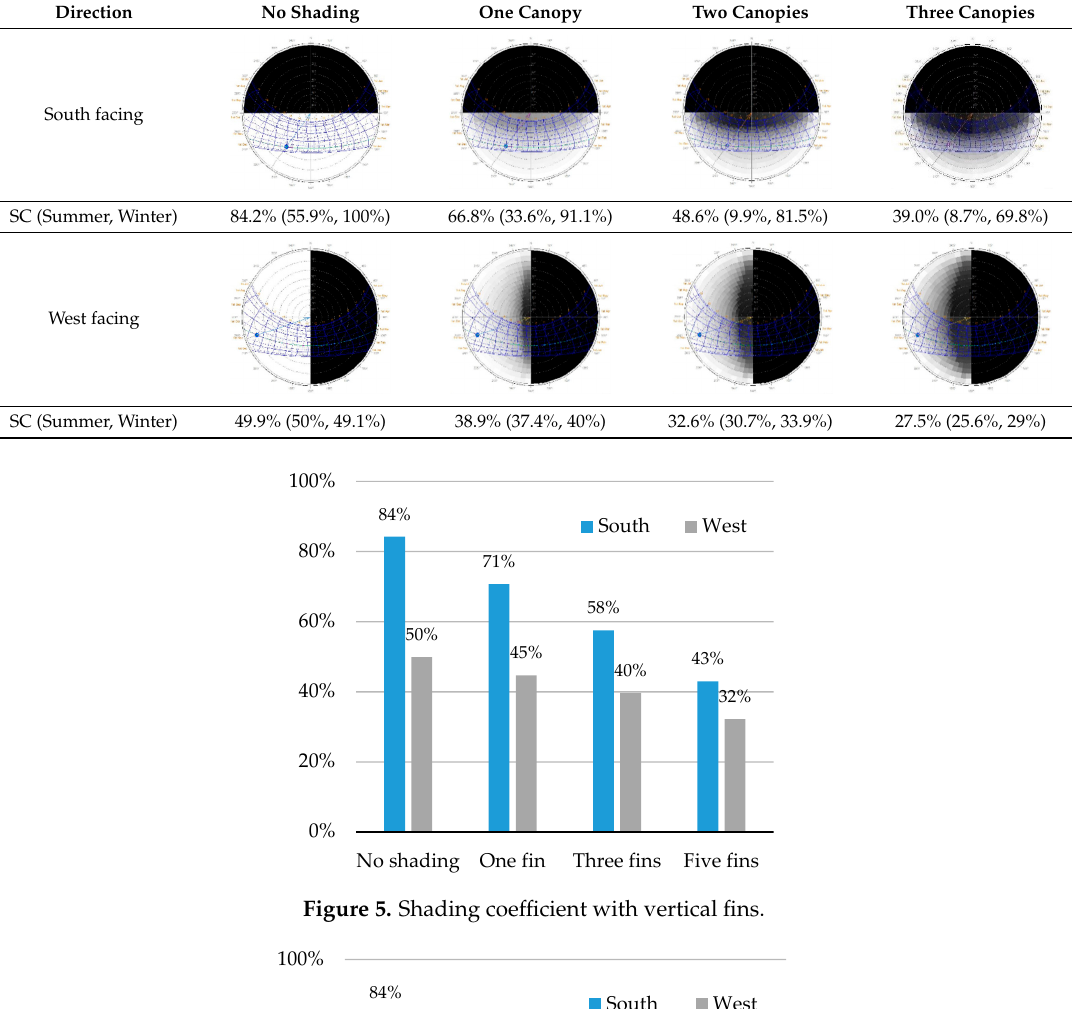
Table 4. Shading mask on the window south facing with horizontal canopies shadings. One Canopy Two Canopies Three Canopies No Shading